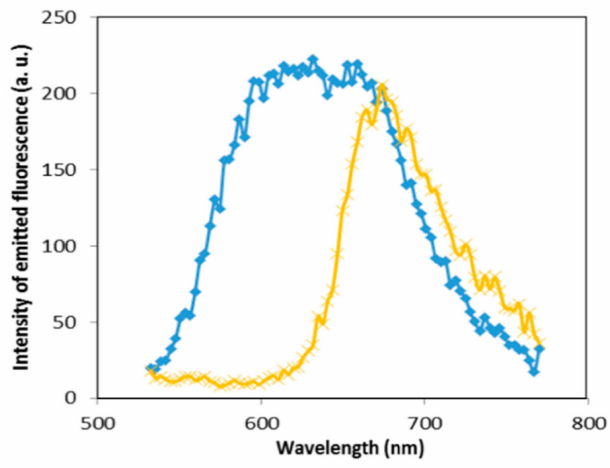
Figure 7. Fluorescence spectra of NB bound to precipitated DNA in the absence (yellow) and in the presence (blue) of GNPs aggregation recorded with lambda scan mode in respectively points marked as a and b in Figure 6B. The emission is obtained under an excitation of 514 nm and it is detected in the (530–775) nm